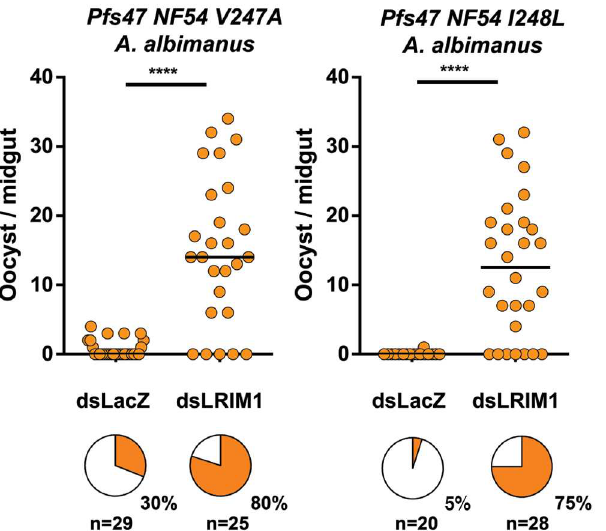
Fig 4. Effect of LRIM1 silencing in A . albimanus mosquitoes on its infection with P . falciparum Pfs47 NF54 V247Aand I248L. Effect of silencingthe leucine-richrepeat immune protein 1 (LRIM1) in A . albimanus on infectionwith NF54 Pfs47 haplotypes V247A and I248L. Each dot representsthe number of parasite on an individual mosquitoand the median is indicatedwith a black line (n = number of midguts examined).The orangearea of the pie charts indicatesthe prevalence of infection. All parasite phenotypes were confirmedin two independentexperiments. Median numberof oocysts were comparedusing the Mann–Whitney test. **** P <